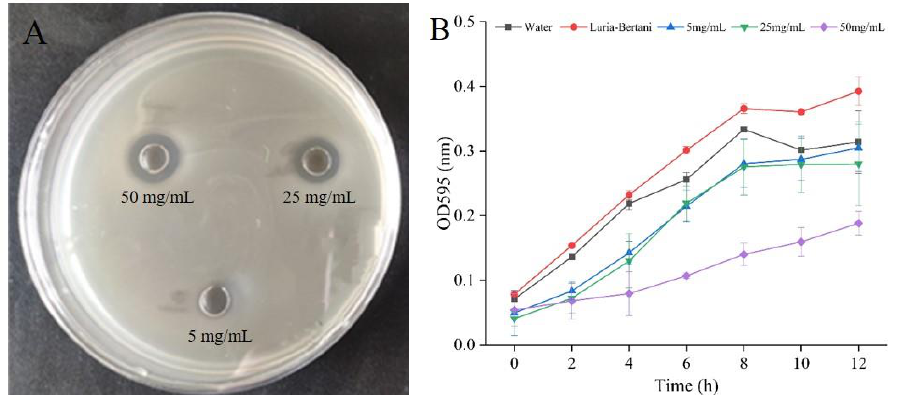
Figure 1. Antibacterial activity of the skin mucus extract against S. aureus : ( A ) zone of inhibition; ( B ) growth curves of S. aureus treated with different concentrations of the skin mucus extract.